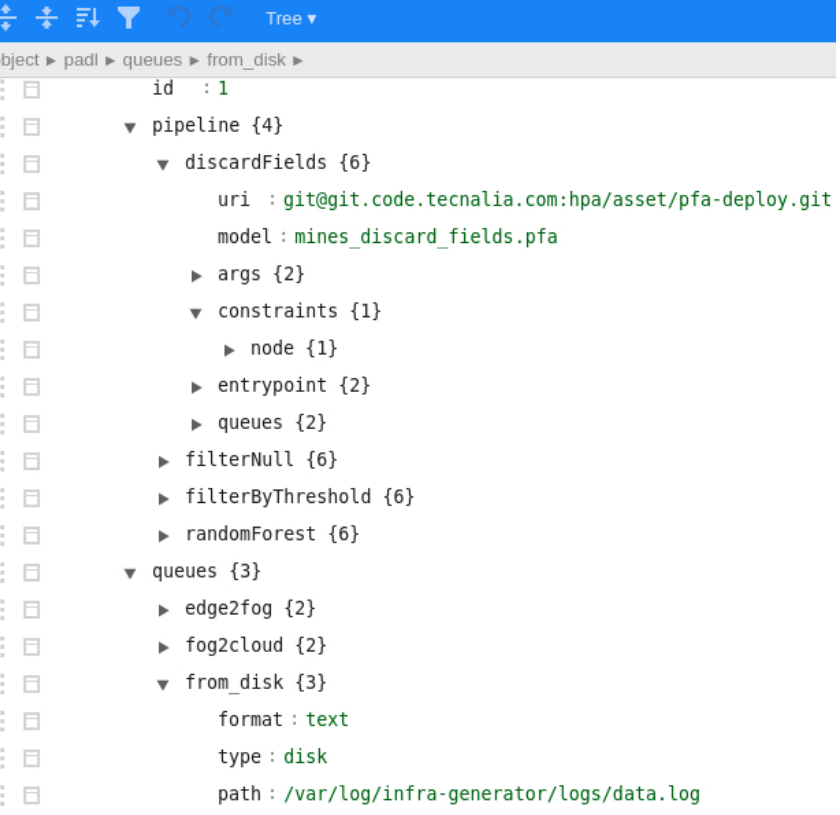
Figure 10. Screenshot of the client when editing the PADL pipeline definition. The four steps of the pipeline are defined and specific properties can be observed such as the URI where the code is located, the model to be executed and the queues